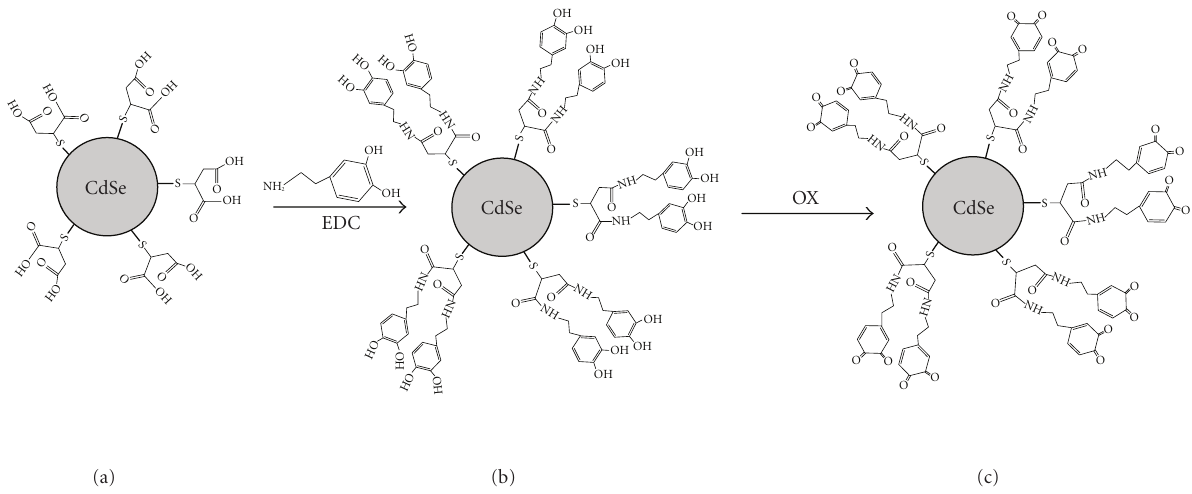
Figure 1: Schematic of QD-dopamine conjugate preparation and mechanism of redox sensitivity. (a) MSA-capped QD. (b) Upon addition of dopamine (structure shown above arrow) and the zero-length cross-linker EDC, an amide bond is formed between the amine of dopamine and the carboxylate groups of MSA. This schematic shows 100% linkage of dopamine to MSA termini; however, we show here that this ratio can be controlled. (c) Upon oxidation (“OX”), the catechol becomes a less-soluble quinone.